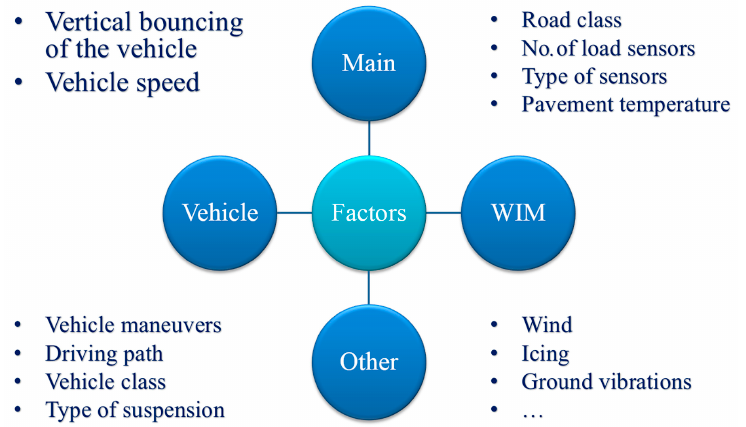
Figure 2. Factors affecting the weighing accuracy with division according to the source of their occurrence (vehicle or WIM system) or degree of influence (main or other).